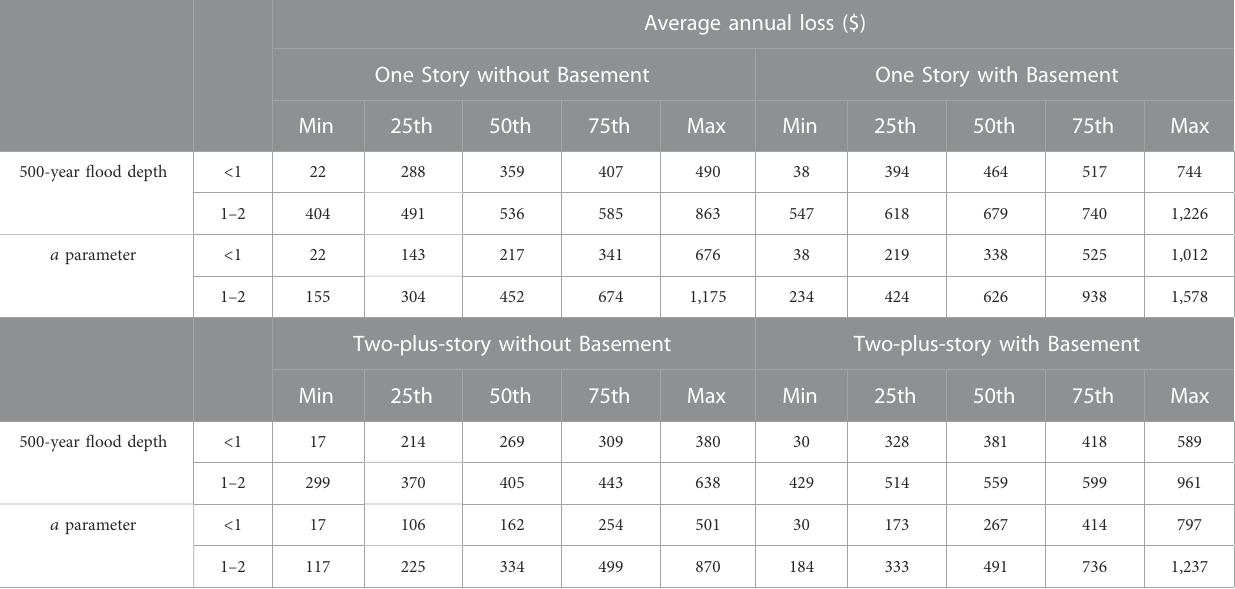
TABLE 11 Descriptive statistics of average annual loss ($; i.e., annual fl ood risk) by type of single-family home, after implementing synthetic fl ood parameters, by 500-year fl ood depth and a parameter.